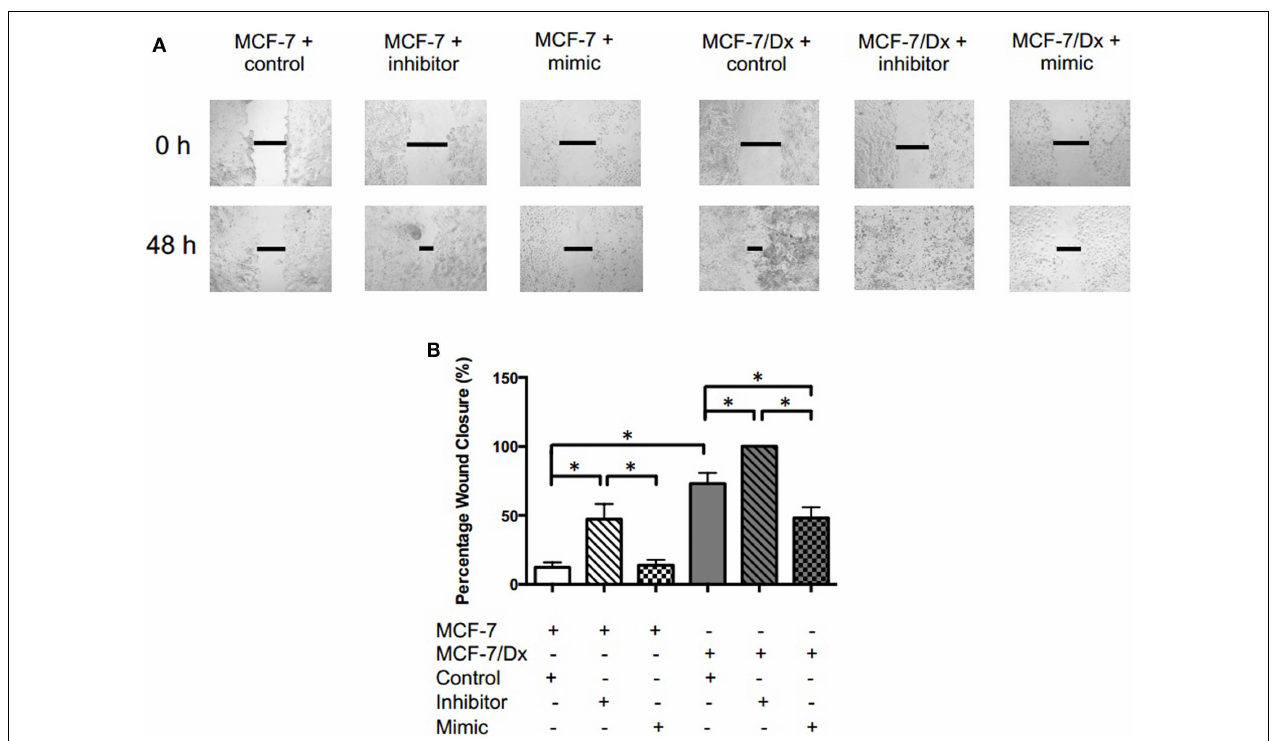
transfected breast cancer cells. Percentage wound closure observed in ( ): MCF-7 cells transfected with the scrambled control, ( ): MCF-7 cells transfected with the miR-503 antagomiR, ( ): MCF-7 cells transfected with the miR-503 pre-miR, ( ): MCF-7/Dx cells transfected with the scrambled control, ( ): MCF-7/Dx cells transfected with the miR-503 antagomiR, and ( ): MCF-7/Dx cells transfected with the miR-503 pre-miR. Data represent the mean ± SEM of at least three independent experiments. * p <